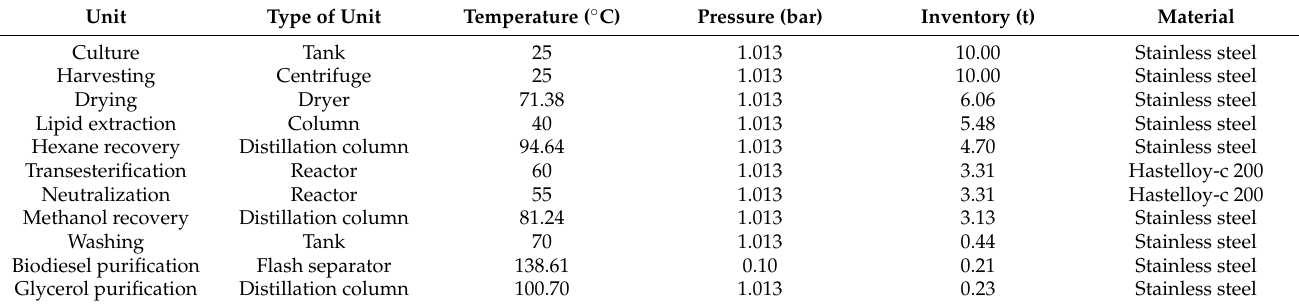
Table 4. Description of the main unit used for biodiesel production from microalgae via conventional.